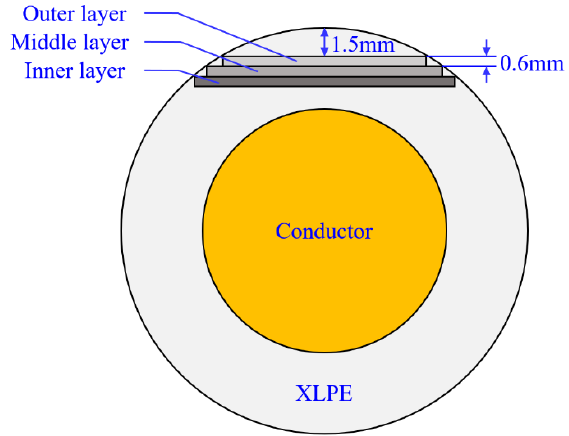
Figure 5. Schematic diagram of cable insulation crosscutting.